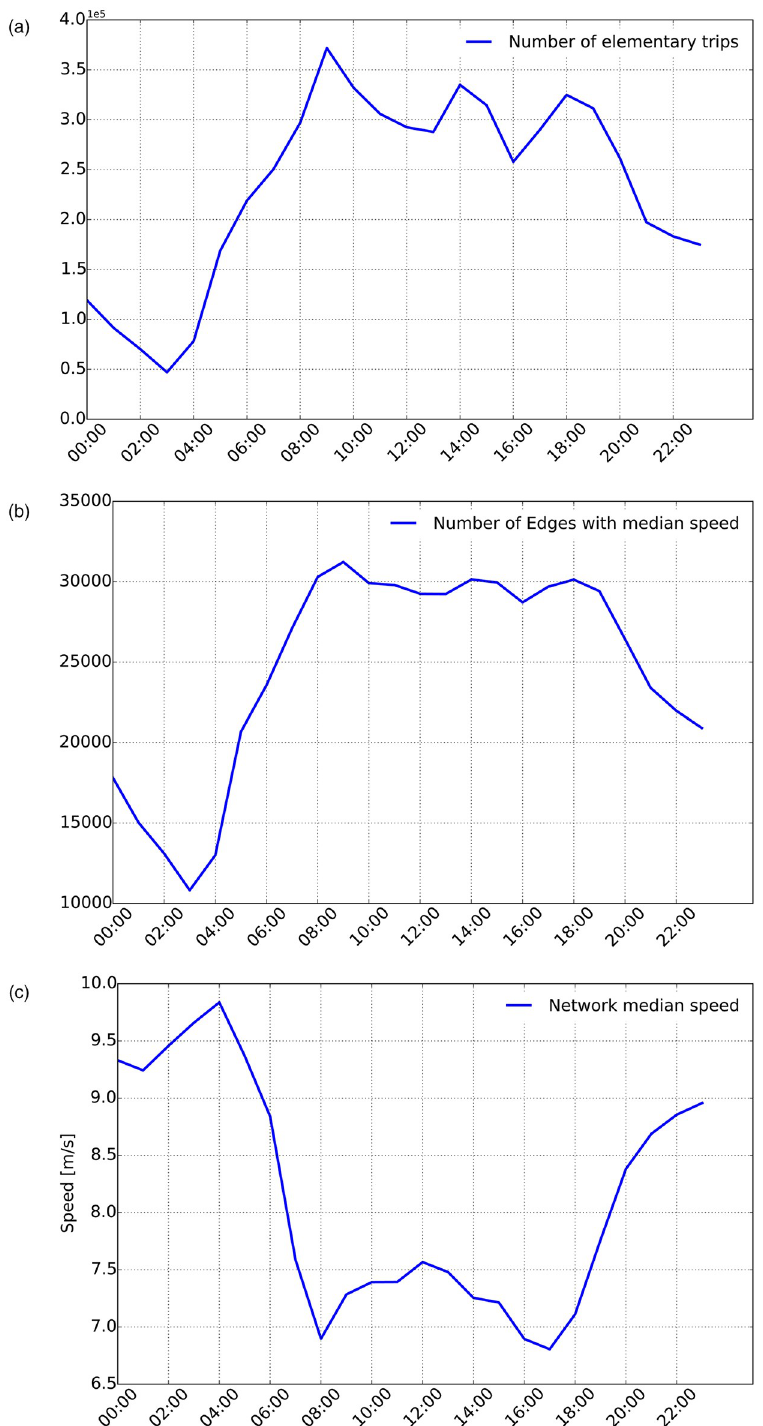
Fig 2. Spatio-temporal characterization of taxi observations. (a) Hourly number of elementary trips for the typical working day (b) Number of edges from the Rhone-ROADS with median speed (c) Evolution of the network median edge-speed over